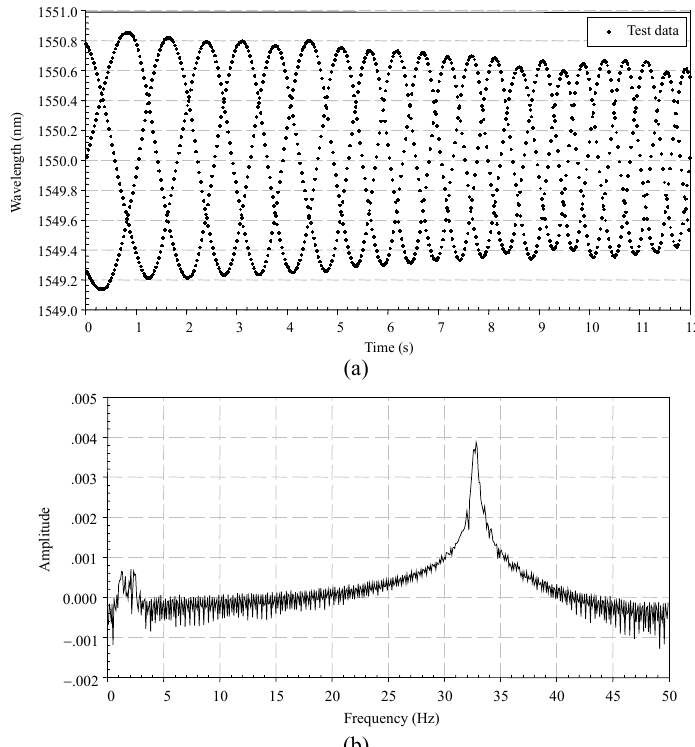
Fig. 5 Test data and FFT analysis with the vibration source at 35 Hz: (a) test data and (b) FFT spectral curve after treatment.